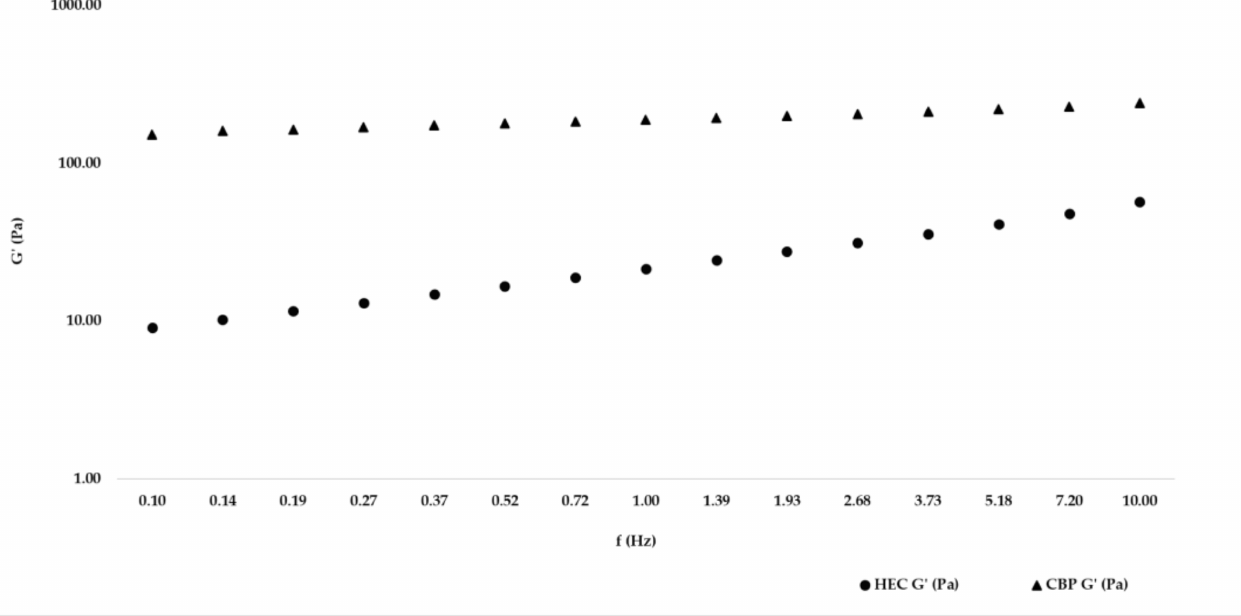
Figure 3. Graphical representation of frequency sweep G’ obtained with the formulation with hydroxyethylcellulose (HEC) and formulation with carbopol (CBP) at a temperature of 25 ◦ C and at a shear strain value of 1%.